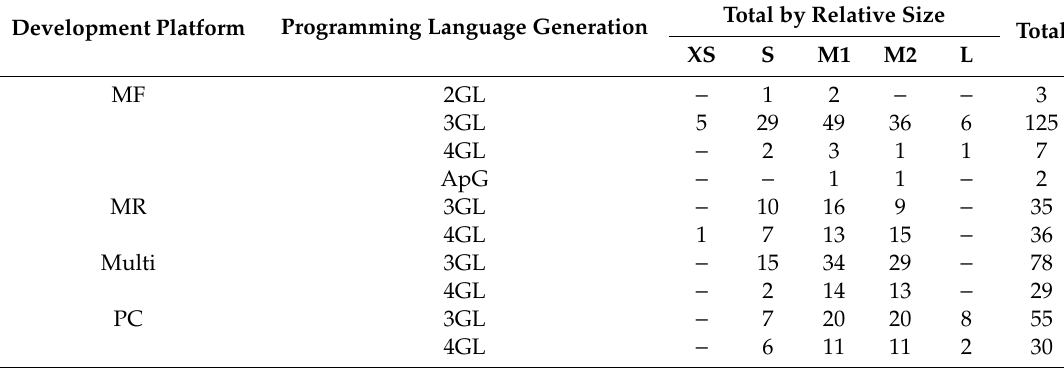
Table 2. Enhancement projects classified by relative